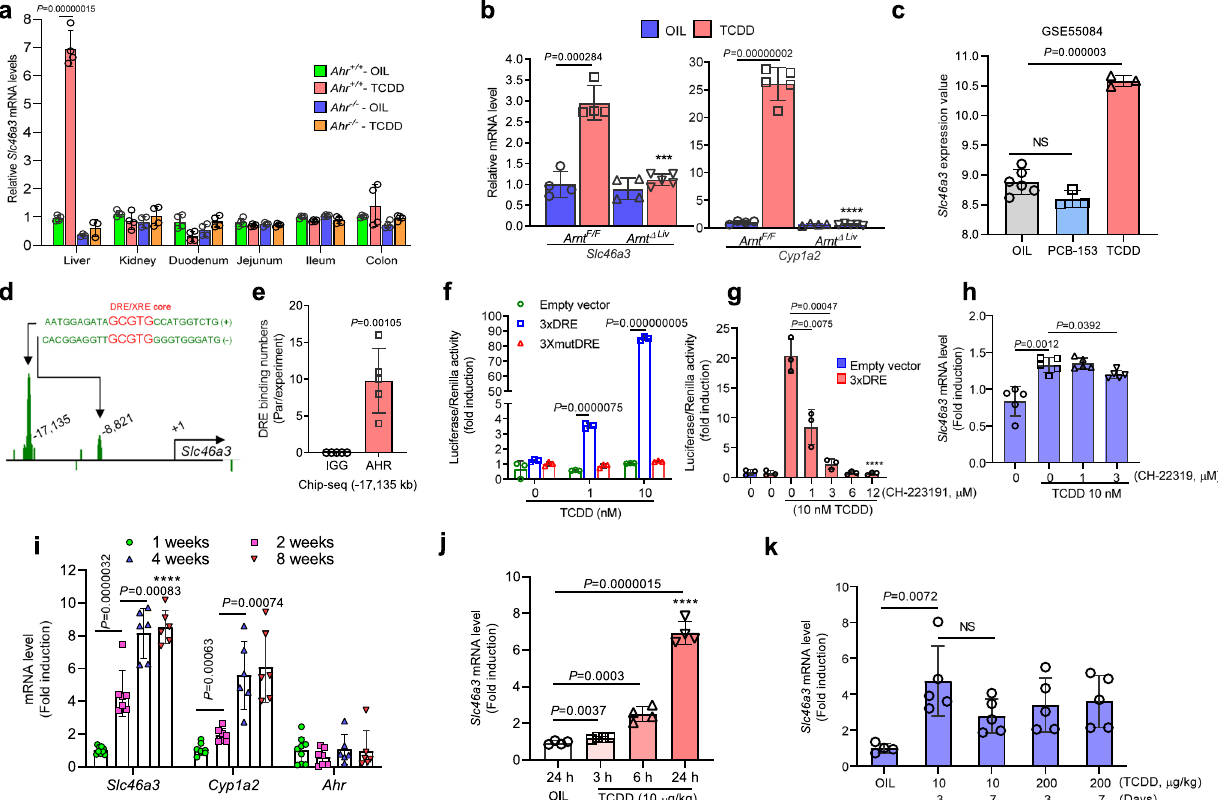
Fig. 1 Regulation of Slc46a 3. a Slc46a3 mRNA expression in different mouse tissues after oil ( n = 3 – 4 per group) or TCDD (10 µ g/kg for 24h)( n = 3 – 4 per group) administration. b Hepatic Slc46a3 mRNA expression after oil ( n = 4 per group) or TCDD (10 µ g/kg for 24h)( n = 5 group) administration in Arnt − / − mice. Two-way ANOVA with Bonferroni ’ s multiple comparisons tests, *** p <0.0002, **** p <0.0001. c Male mouse liver transcription pro fi ling by Affymetrix microarray (GEO: GSE55084) shows Slc46a3 mRNA after treatment with PCB-153 (IP injection, 80mg/kg for 48h) and TCDD (IP injection, 10 µ g/kg for 48h). Oil ( n = 6 per group), PCB-153 ( n = 3 per group), TCDD ( n = 3 per group). NS not signi fi cant. d Putative DRE/XRE binding sites of Slc46a3 promoter were extracted using ChIP-seq data (GEO accession: GSE97634) and possible enhancer region (~ − 17,135bp from the 5 ′ - fl anking region of Slc46a3 ) was analyzed using original fi le sets using Integrated Genome Browser (Bioviz). e Counting of putative dioxin-responive enhancer (DRE)/xenobiotic response element (XRE) region ( − 17,135bp of Slc46a3 ) binding by AhR after TCDD administration in mouse liver ( n = 5 per group). The ChIP-seq data set was from Gene Expression Omnibus (Geo, accession: GSE97634). f Luciferase assay using putative 3×DRE enhancer region ( − 17,135bp) of Slc46a3 gene in the Hepa1c1c7 cells. Cells were transfected with 3×DRE or 3×mutDRE luciferase constructs ( n = 3 biologically three independent experiments) overnight and treated with indicated doses of TCDD for 6h. g Inhibitory effect of the AhR inhibitor, CH-223191, on the putative 3×DRE luciferase activity in Hepa1c1c7 cells. After transfection with the 3×DRE luciferase plasmid ( n = 3 biologically three independent experiments), cells were co-treated with different concentrations of CH-223191 with/without 10nM TCDD for 6h. Transfection was normalized with the Renilla luciferase signal. One-way ANOVA with Tukey ’ s multiple comparisons test, **** p <0.0001. h Inhibitory effects of the AhR antagonist CH-223191 on TCDD-induced Slc46a3 mRNA in Hepa1c1c7 cells ( n = 5 biologically independent samples). i Expression of hepatic Slc46a3 , Cyp1a2 , and Ahr mRNAs as a function of mouse age ( n = more than 6 per group). One-way ANOVA with Tukey ’ s multiple comparisons test, **** p <0.0001. j Expression of hepatic Slc46a3 , Cyp1a2, and Ahr mRNAs as a function of time after TCDD treatment ( n = 4 per group). One- way ANOVA with Tukey ’ s multiple comparisons test, **** p <0.0001. k Expression of Slc46a3 mRNA as a function of dose and time of oil ( n = 4 per group) or TCDD ( n = 5 per group) treatment. Each data point represents the mean ± SD and adjusted p value, presented in the panels, was determined by unpaired two- tailed Student ’ s t test using indicated sample sizes and